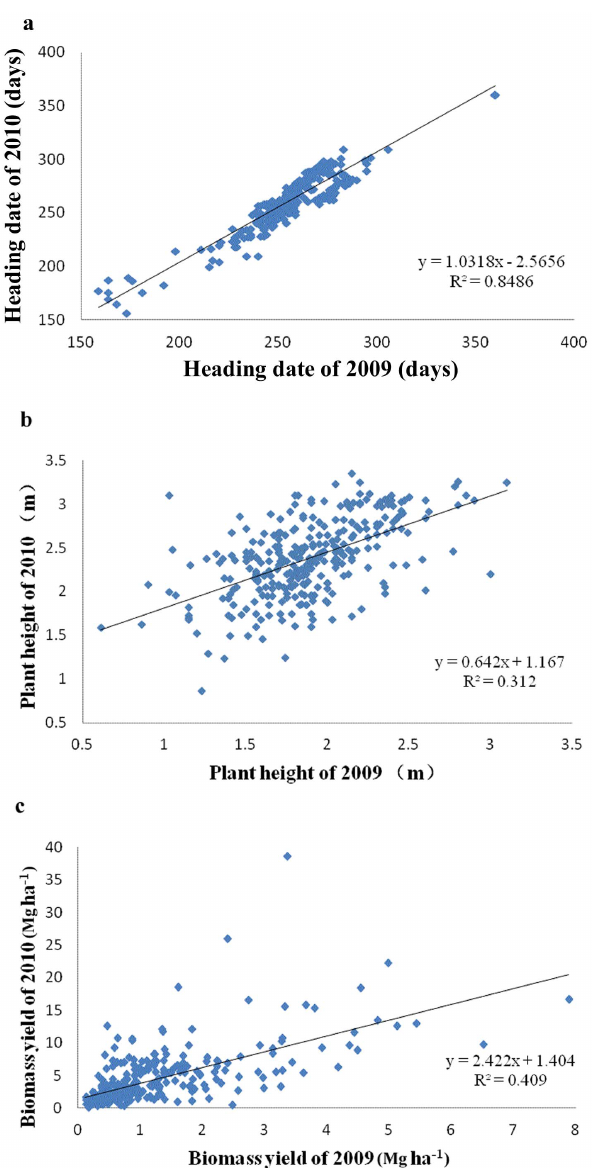
Figure 3. Phenotypic distribution of heading date, plant height and biomass yield in 300 M . sinensis accessions. a) heading date, b) plant height and c) biomass yield in the 1 st (2009) and 2 nd (2010) year after the Miscanthus field was established.